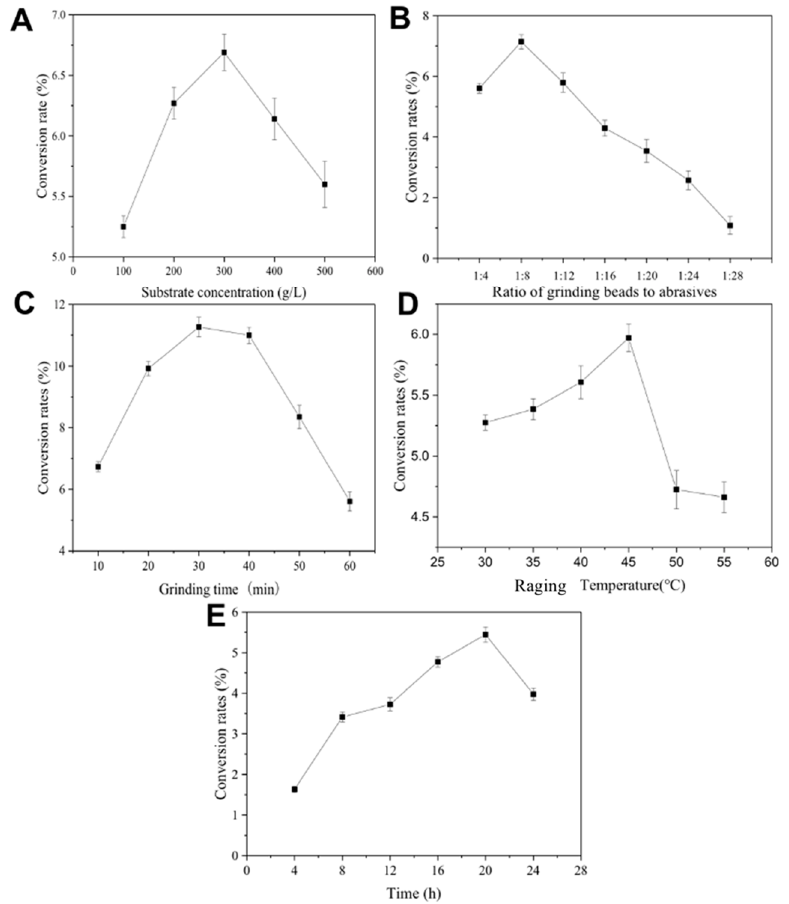
Figure 5. Optimizations of liquid-assisted grinding (LAG) and Raging for GlcNAc production. ( A ) Substrate concentration; ( B ) ratio of beads to abrasives; ( C ) grinding time; ( D ) raging temperature; ( E ) reaction time. Data are given as means ± standard deviation, n = 3. The conditions: ( A ) beads 80 g, chitinase 5 g, 10 mL sodium acetate buffer with pH 5.5, 451 rpm grinding for 30 min, and Raging at 53 °C for 12 h, and different concentrations of chitin powder were set; ( B ) chitin powder 5 g, chitinase 5 g, and 10 mL sodium acetate buffer with pH 5.5, 451 rpm grinding for 30 min, and Raging at 53 °C for 12 h, different concentrations of beads were set; ( C ) chitin powder 5 g, chitinase 5 g, 10 mL sodium acetate buffer with pH 5.5, beads 80 g, 451 rpm grinding, and Raging at 53 °C for 12 h, and different grinding times were set; ( D ) chitin powder 5 g, chitinase 5 g, 10 mL sodium acetate buffer with pH 5.5, beads 80 g, 451 rpm grinding for 30 min, and Raging for 12 h, and different Raging temperatures were set; ( E ) chitin powder 5 g, chitinase 5 g, 10 mL sodium acetate buffer with pH 5.5, beads 80 g, 451 rpm grinding for 30 min, and Raging at 53 °C, and different Raging times were set. 4. Discussion As the previous study reported, the OfHex1 gene has been expressed in P. pastoris , which indicated that P. pastoris is an ideal system for recombinant chitinase expression, due to its excellent secretion activity and specific glycosylation modification [13]. Thus, we selected this system for producing the three recombinant chitinases, i.e., OfHex1, CmChi1, and TcChi1, for the degradation of chitin, in order to produce GlcNAc. The ac- tivity of the recombinant OfHex1 was similar with the previous report [13]. It is worth mentioning that the specific activity of the recombinant CmChi1 from the P. pastoris sys- tem (0.7U/mL) was nearly two times that from E. coli (0.4U/mL) [23]. Moreover, the char- acteristics of the recombinant chitinase expressed in P. pastoris were obviously different from those in other expression system. For example, the TvChi1 and CmChi1 derived